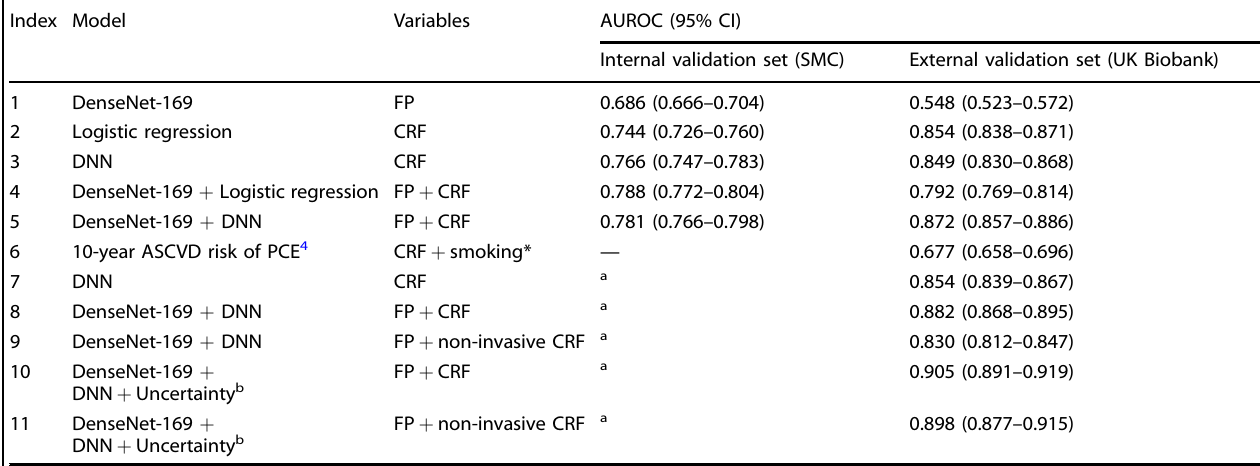
Table 2. Area under the receiver operating characteristic curves in the internal validation set and the external validation